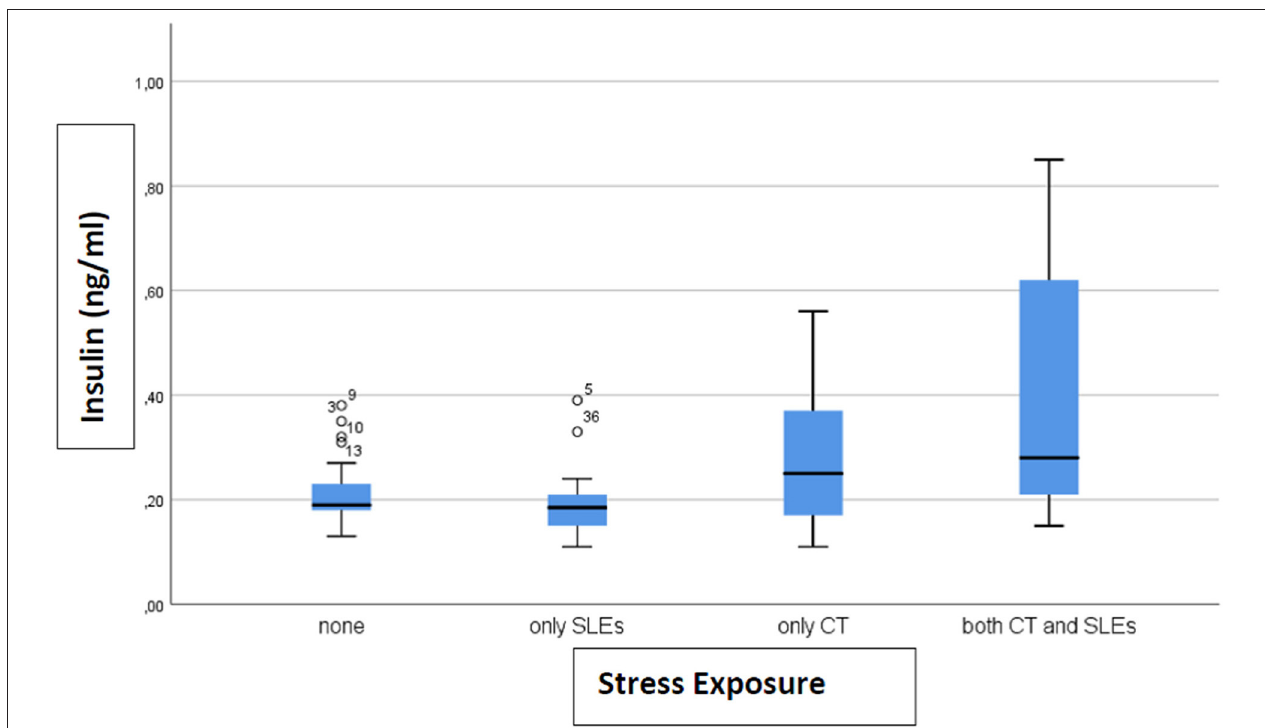
FIGURE 2 | The box-plot for insulin serum concentration distribution in subjects who experienced different exposure to childhood trauma (CT) and severe stressful life events (SLEs) ( n = 72).